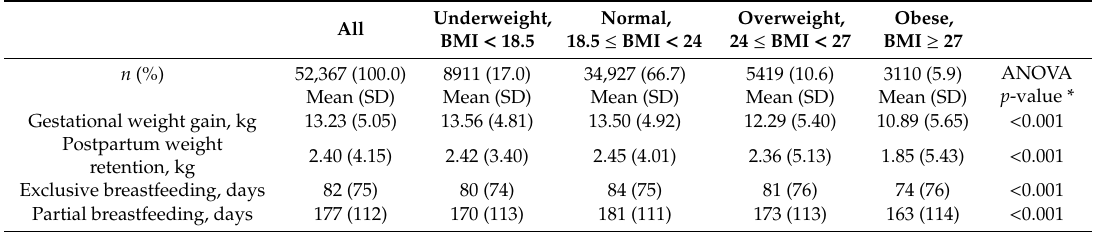
Table 2. Distribution of gestational weight gain, postpartum weight retention and breastfeeding duration by pre-pregnancy body mass index in Taiwanese women ( N =